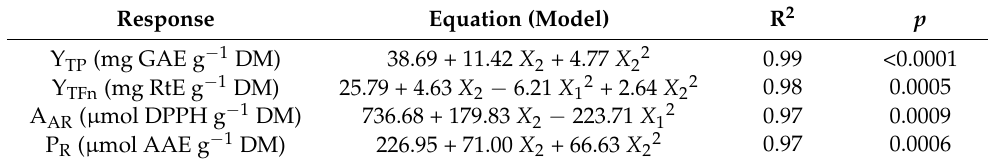
Table 3. Equations (models) are constructed by the response surface methodology for each re- sponse